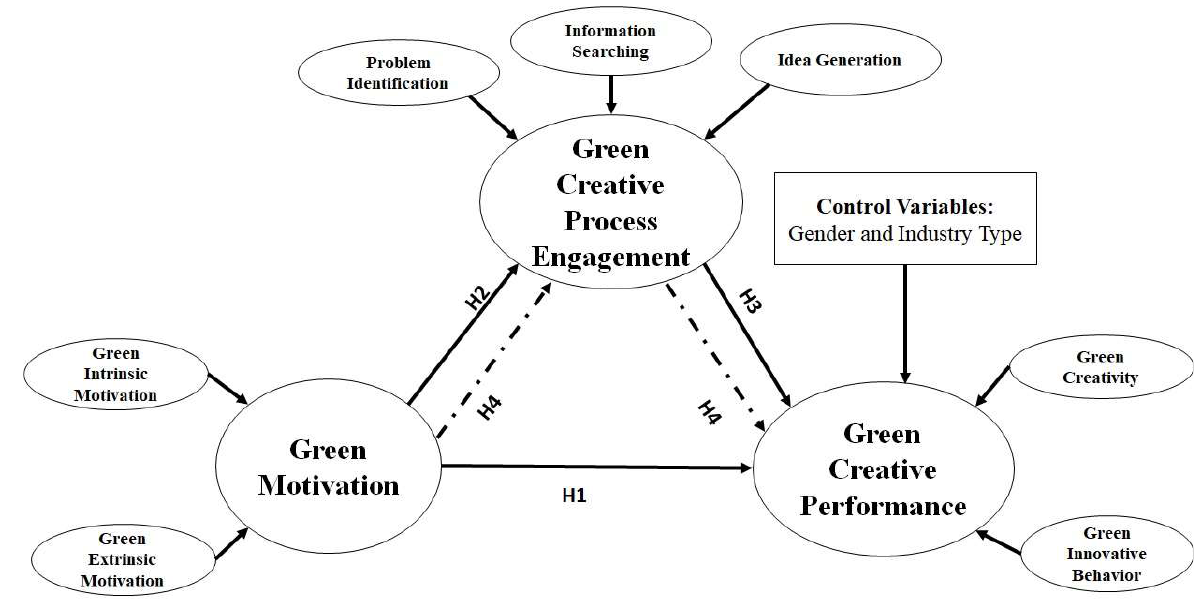
Figure 1. Conceptual Framework.